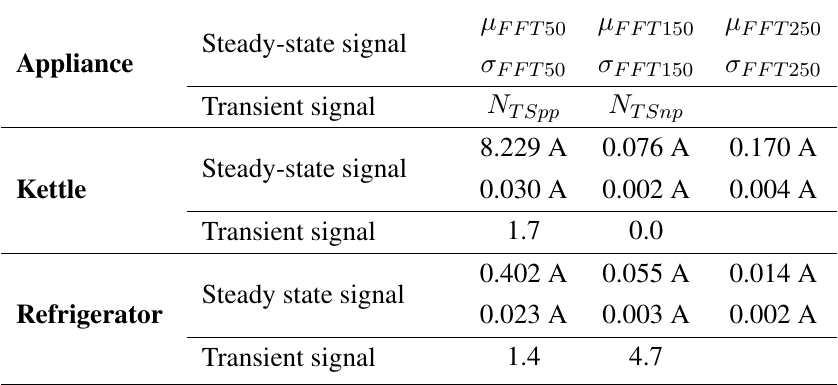
Table 5. An example entry in the signature library for two appliances (one of each